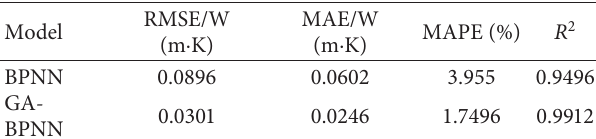
Figure 6: The prediction results and measured results of testing data. Table 2: Calculation results of performance indexes for GA-BPNN and